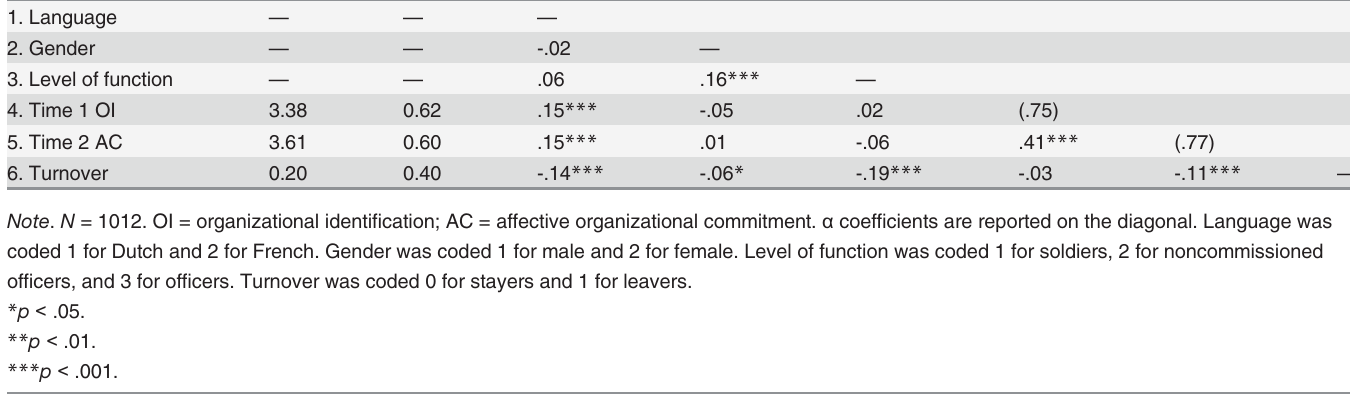
Table 4. Study 3: Descriptive Statistics and Intercorrelations Among Variables.